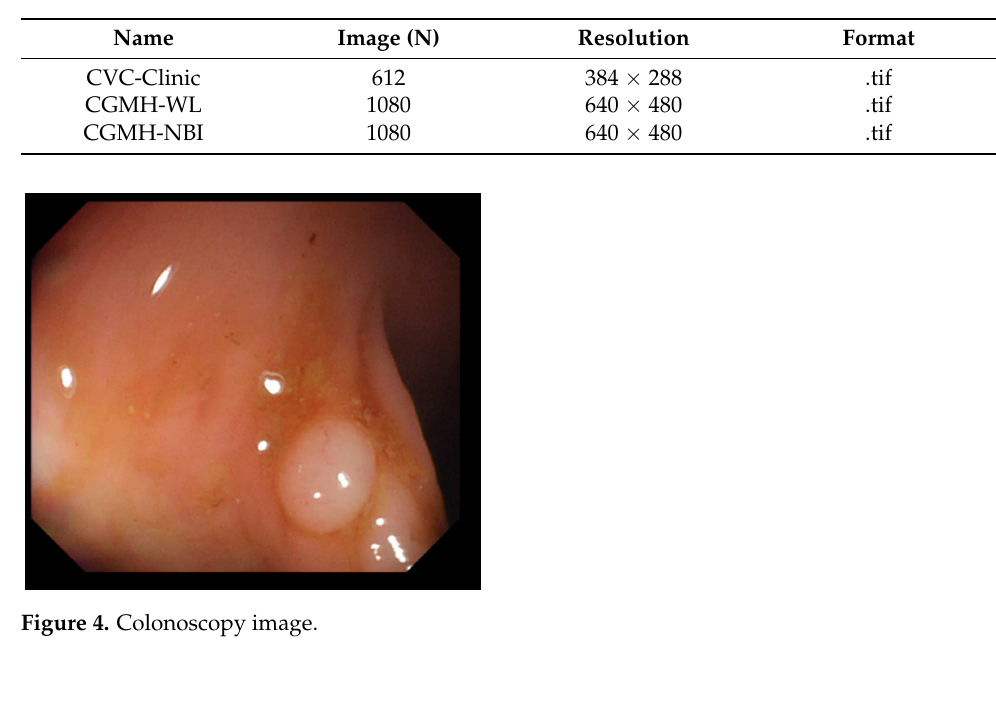
Figure 5. Segmented polyp image. Figure 6 presents the architecture for the colorectal polyp detection and diagnosis system. The system is capable of polyp detection and classification. During colorectal polyp detection, the input colonoscopy images were preprocessed. The images in the data set were converted to grayscale images during preprocessing and applied for feature ex- traction and training to detect the location of polyps. The detected polyps were subse- quently classified into neoplastic polyps (including adenomas and deep submucosal in- vasive cancer) and hyperplastic polyps. Figure 6. System architecture. 2.1. Polyp Detection The main polyp detection procedures involve the conversion of images to grayscale and labeling the location of polyps. During gray scaling, RGB images were converted to grayscale images with pixel values ranging from 0 to 255. RGB pixels were converted to gray pixels by using ITU-R BT.601 [47]: Gray = 0.229 × R + 0.587 × G + 0.117 × B (1) where R, G, and B are the pixel values of the red, green, and blue colors in color images, respectively (Figures 7 and 8).